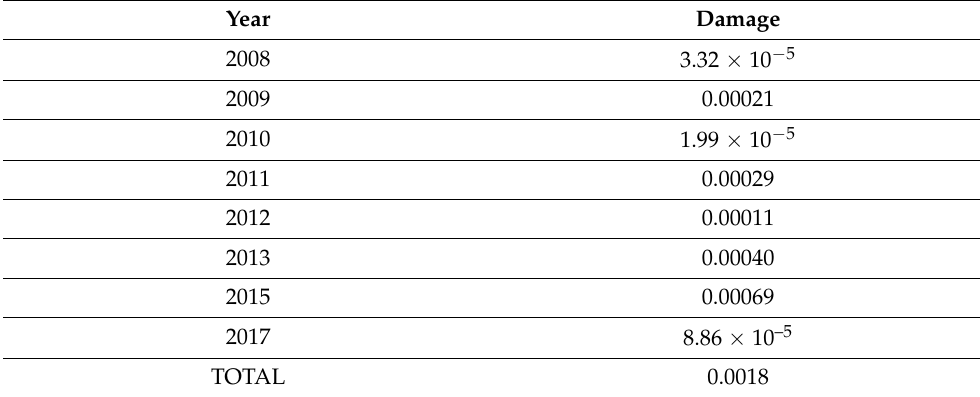
Table 4. FEA loading table by years.